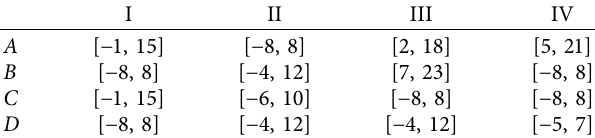
Table 5: Subtraction of the minimum interval in each